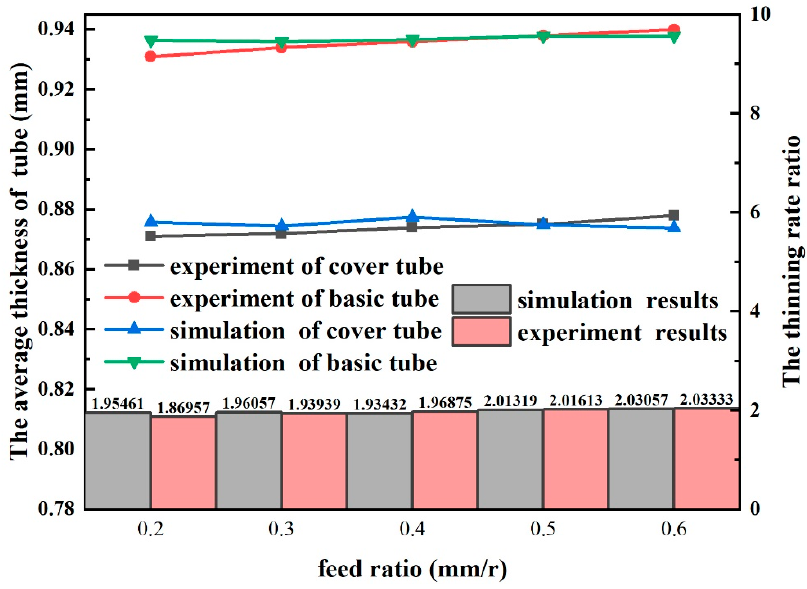
Figure 9. Variation of average thickness and ratio of thinning rate after rotary ring spinning with di ff erent feed ratios.